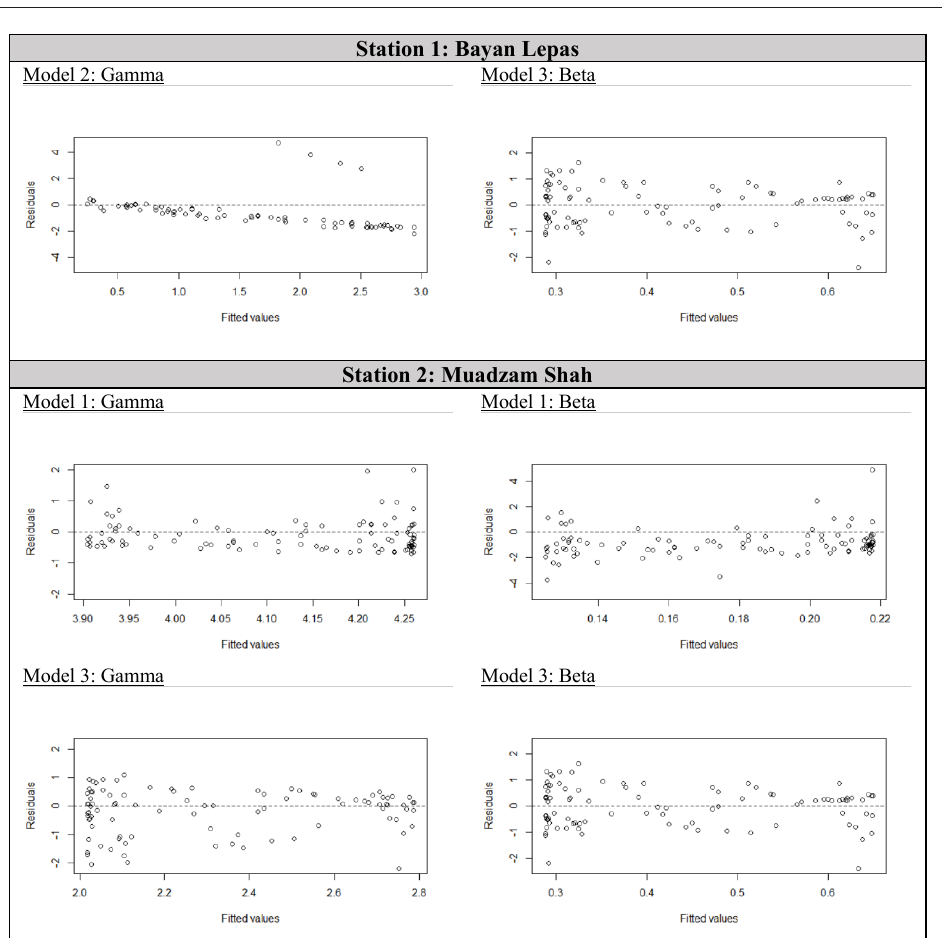
Fig. 5. Residual plots for significant models at Station 1 and Station